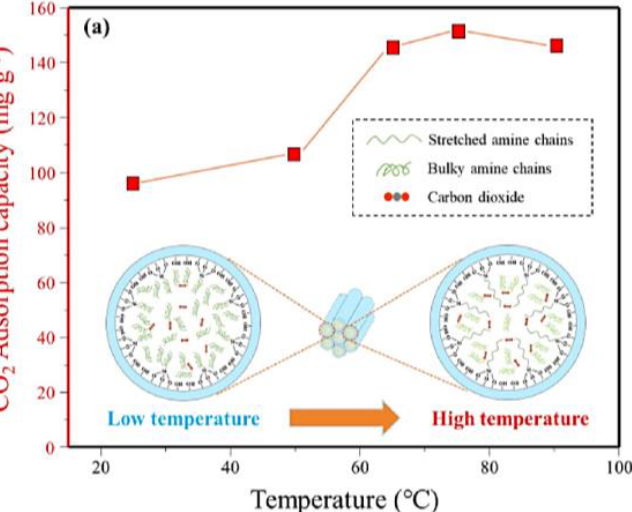
Figure 6. The effect of the operation temperature on the adsorption of CO 2 on 70TMM-550 adsorbent. Reproduced with permission from [78].